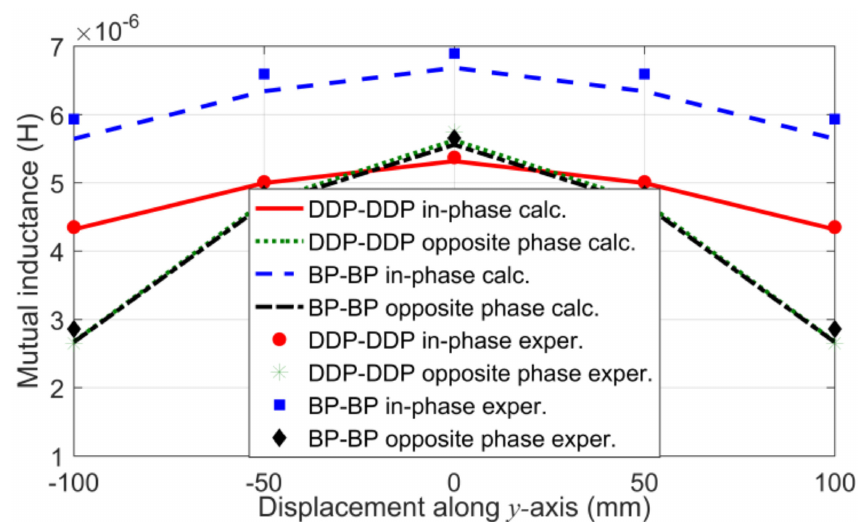
Figure 9. Experimental results and calculation results of mutual inductance for the two polarized couplers under misalignment along the y -axis.